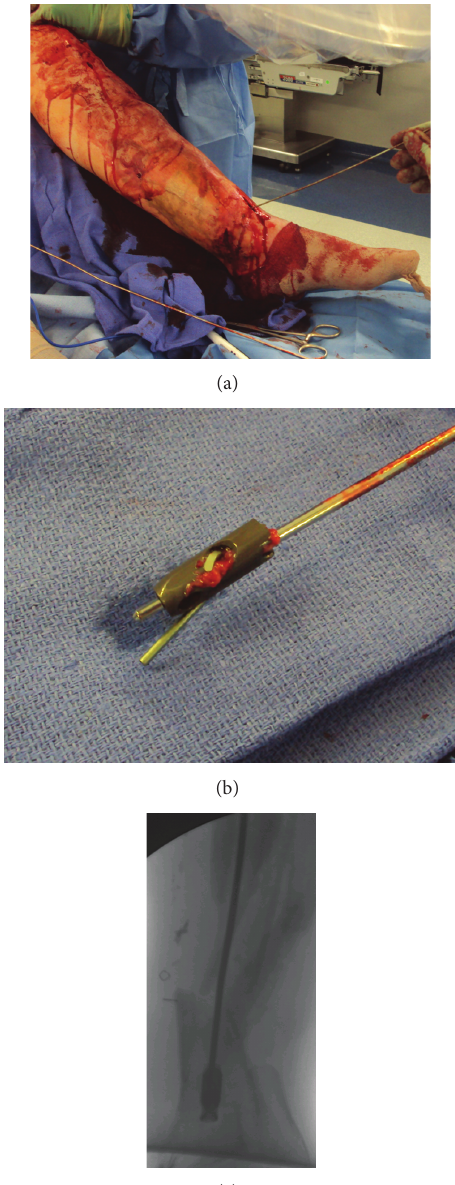
Figure 1: (a) Insertion of the flexible nail from the locking hole. The flexible nail was then cut at a distance of about 2 inches. (b) The broken piece was removed with the hook and the piece of the flexible nail wrapped around the hole of the locking screw. (c) Radiograph during extraction of the broken